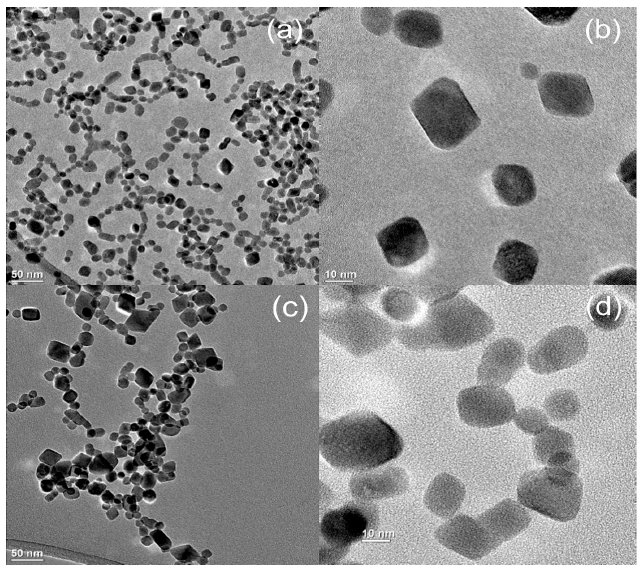
Figure 9. TEM micrographs of samples after hydrothermal treatment at 140 °C. ( a , b ) Sample without NaCl; ( c , d ) Sample with 2.5 mM NaCl.